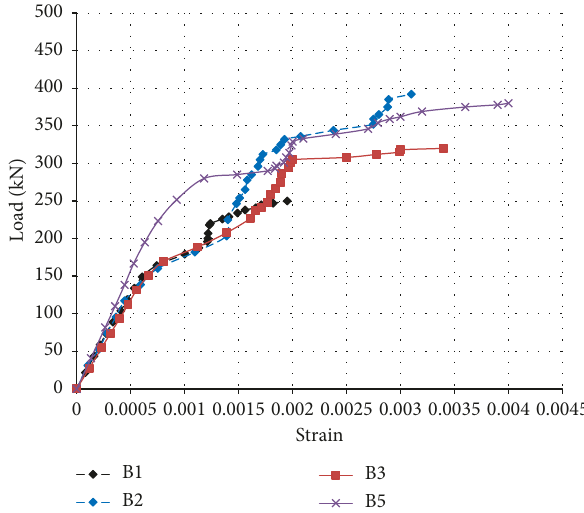
Figure 17: Load strain in concrete performances for models B1, B2, B3, and B5.